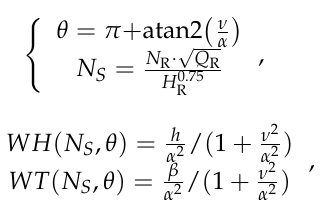
Figure 4. Working sequence of joint adjustment (Scheme JOINT).